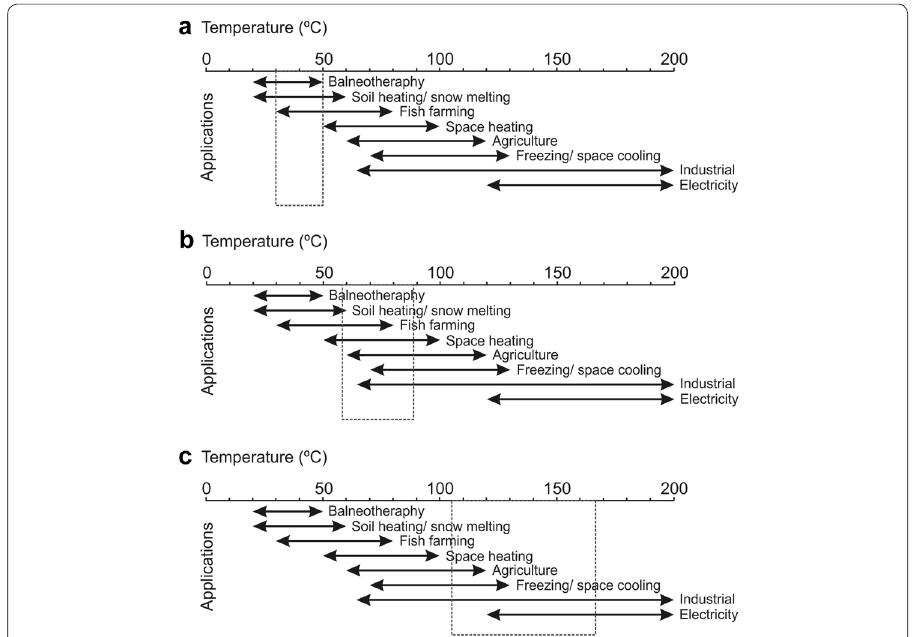
Fig. 9 Lindal diagram correlating geothermal resource temperature in Kuujjuaq with possible utilizations (adapted from Lindal 1973). a worst-case scenario, b base-case scenario, c best-case scenario. The square highlights the temperature range at 5 km obtained by the different temperature simulations